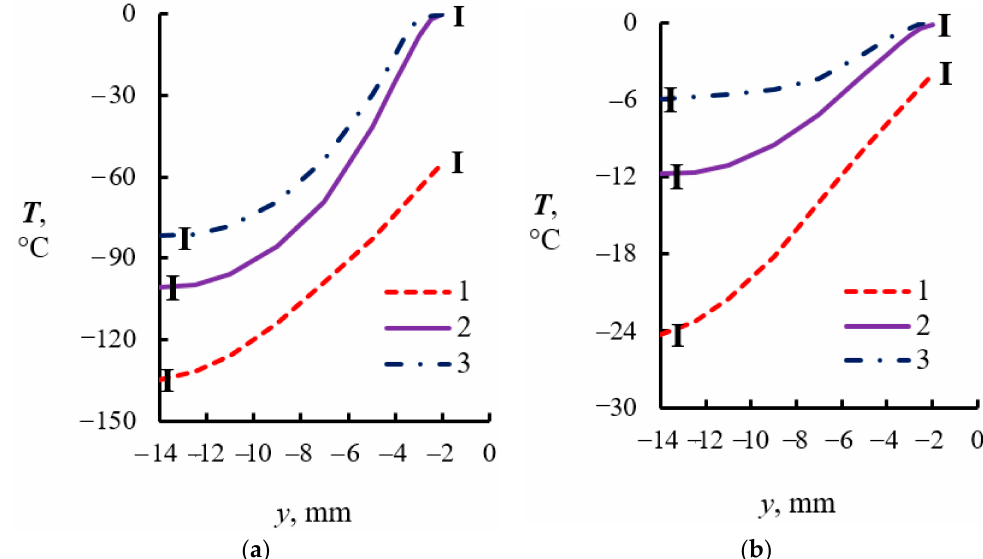
Figure 11. Temperature distribution by the height of the powder layer during combustion of methane hydrate: ( a ) U 0 = 0 m/s; 1 − t = 0 s; 2 − t = 60 s; 3 − t = 110 s; ( b ) U 0 = 0.5 m/s; 1 − t = 0 s; 2 − t = 30 s; and 3 − t = 50 s ( I —intervals of temperature measurement for three repeated experiments).